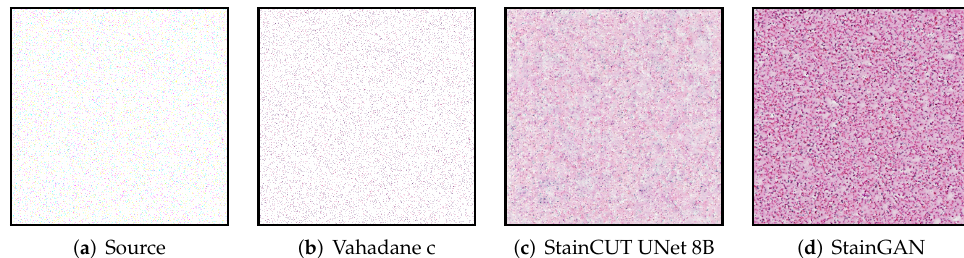
Figure 13. Example of applying the stain transfer (trained with the MITOS-Atypia dataset) to an out of distribution synthetic image (random salt and pepper noise with density 0.03). The result when applying the Vahadane method seems to be consistent; however, the StainCUT and StainGAN methods appear to attempt to create some tissue pattern.